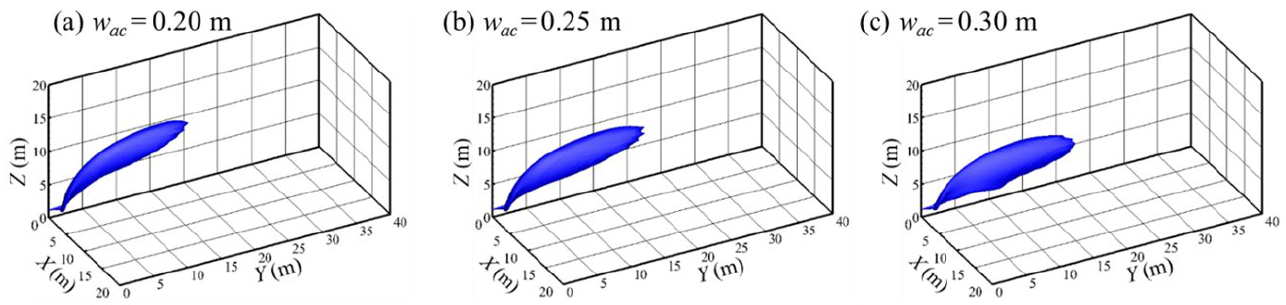
Figure 13. Iso-surface of 4% hydrogen concentration with various w ac values ( Q ac = 12 m 3 /s, d ac = 2 m, t = 100 s).